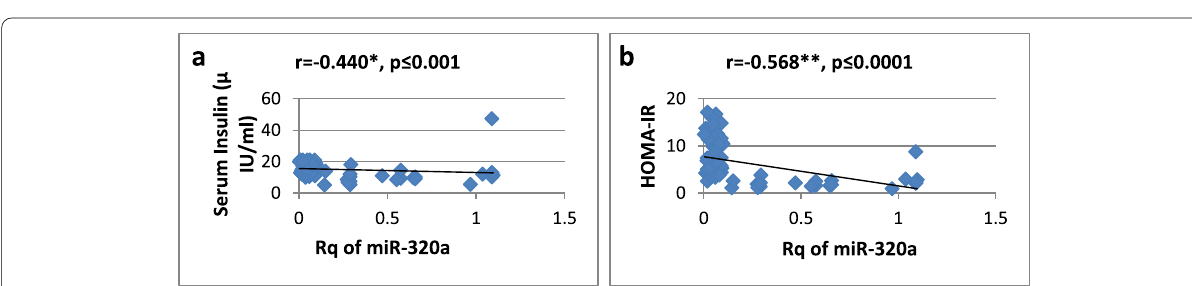
Fig. 9 a , b Correlation coefficient between Rq of microRNA 320‑a and both serum insulin ( r HOMA‑IR ( r 0.568), where “**” means significant at p = −